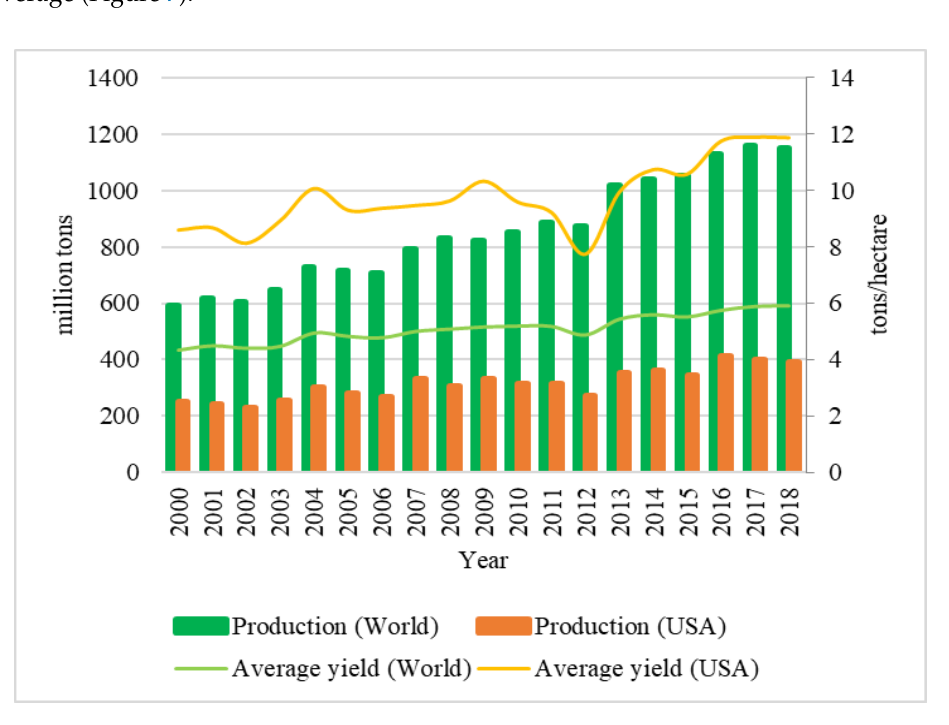
Figure 7. World and US maize production and yield, 2000–2018. Source: [47].